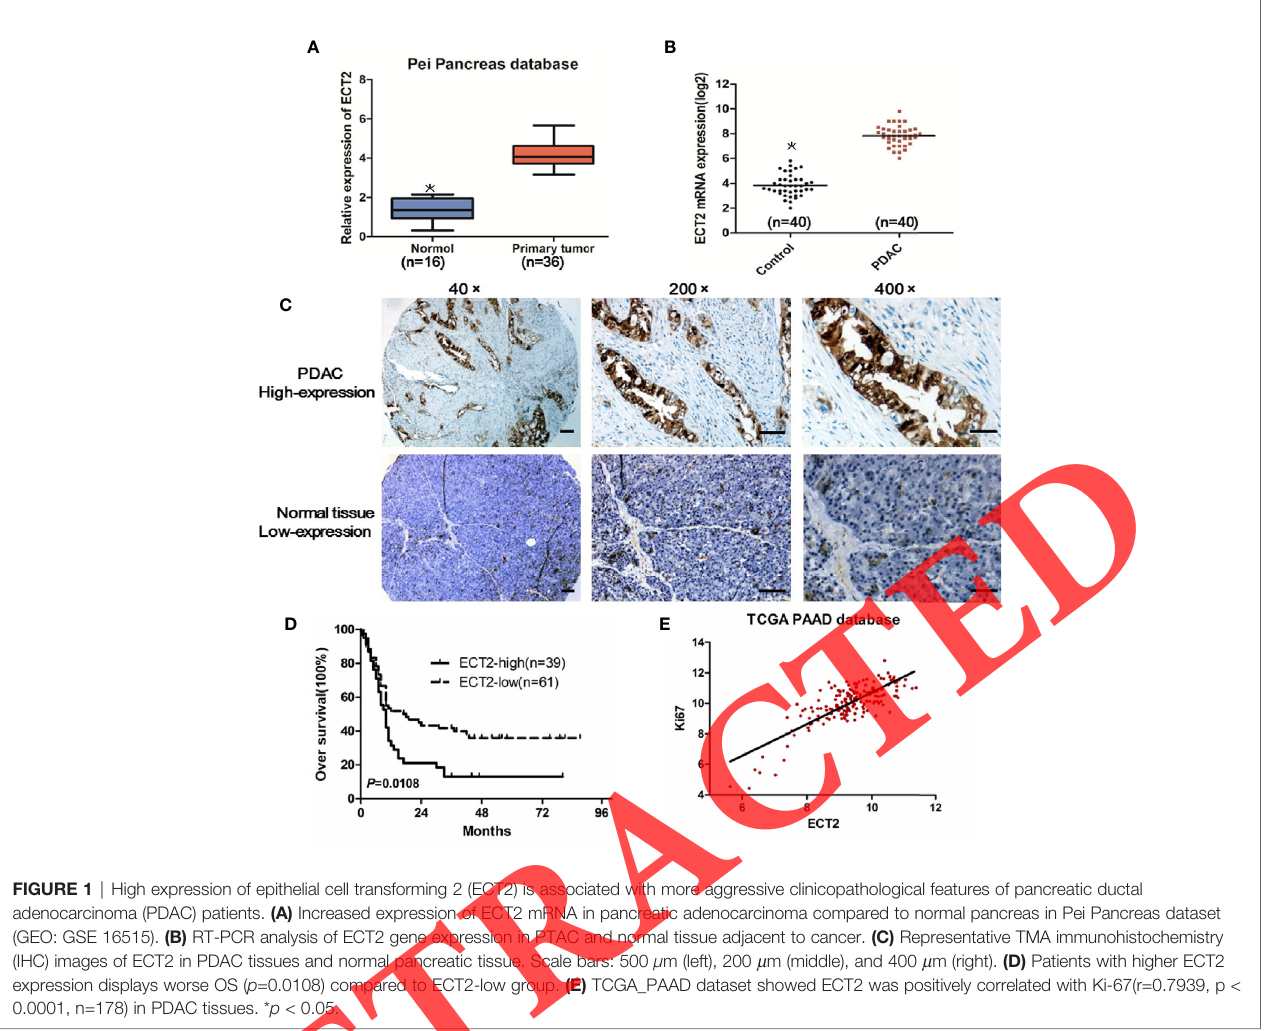
FIGURE 1 | High expression of epithelial cell transforming 2 (ECT2) is associated with more aggressive clinicopathological features of pancreatic ductal adenocarcinoma (PDAC) patients. (A) Increased expression of ECT2 mRNA in pancreatic adenocarcinoma compared to normal pancreas in Pei Pancreas dataset (GEO: GSE 16515). (B) RT-PCR analysis of ECT2 gene expression in PTAC and normal tissue adjacent to cancer. (C) Representative TMA immunohistochemistry (IHC) images of ECT2 in PDAC tissues and normal pancreatic tissue. Scale bars: 500 µ m (left), 200 m m (middle), and 400 m m (right). (D) Patients with higher ECT2 expression displays worse OS ( p =0.0108) compared to ECT2-low group. (E) TCGA_PAAD dataset showed ECT2 was positively correlated with Ki-67(r=0.7939, p < 0.0001, n=178) in PDAC tissues. * p <